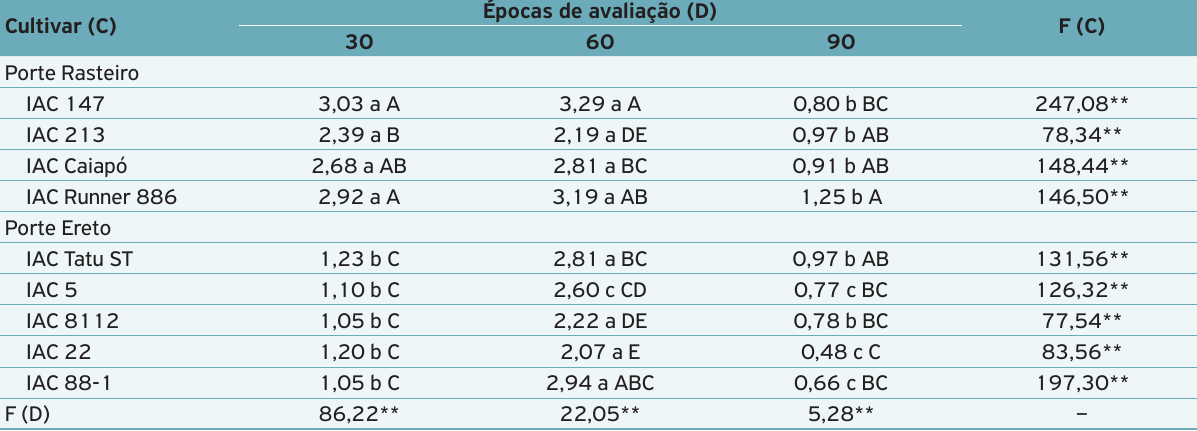
Tabela 4. Valores da análise de desdobramento da interação entre cultivares de amendoim versus épocas de avaliação,